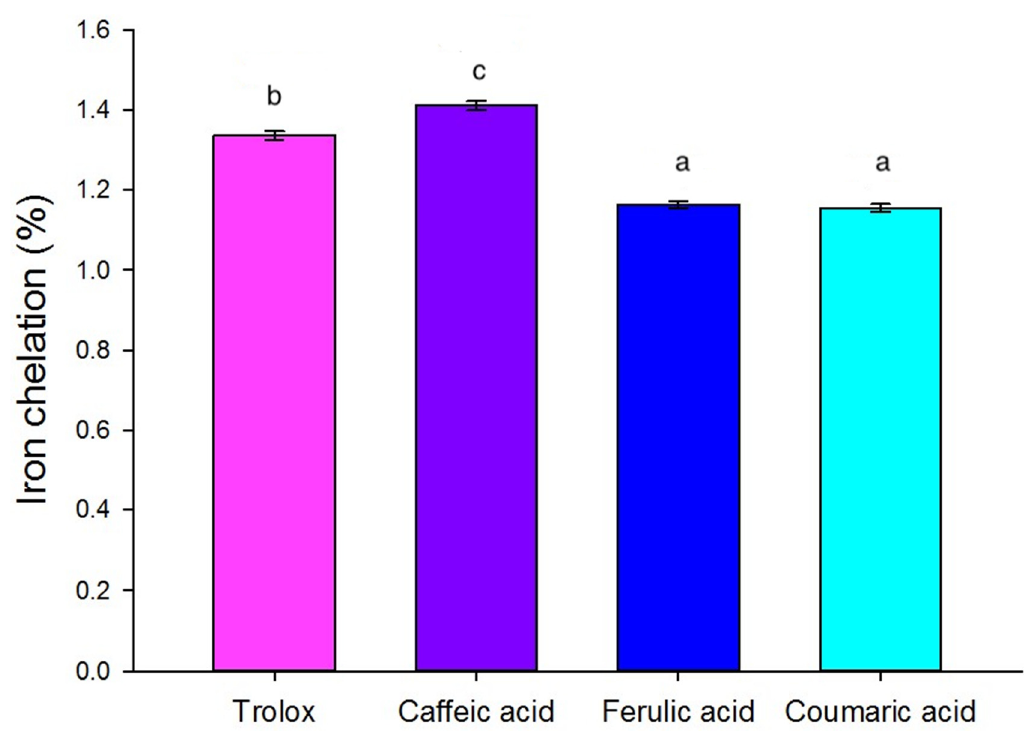
Figure 5. Percentage of iron chelation of pericarp comparison with Trolox, caffeic acid, ferulic acid, coumaric acid (0.1 M). Values reported as percentage (%). Values presented are the average of three replicates ± standard deviation. Different letters indicate that the values are significantly different ( p < 0.05).